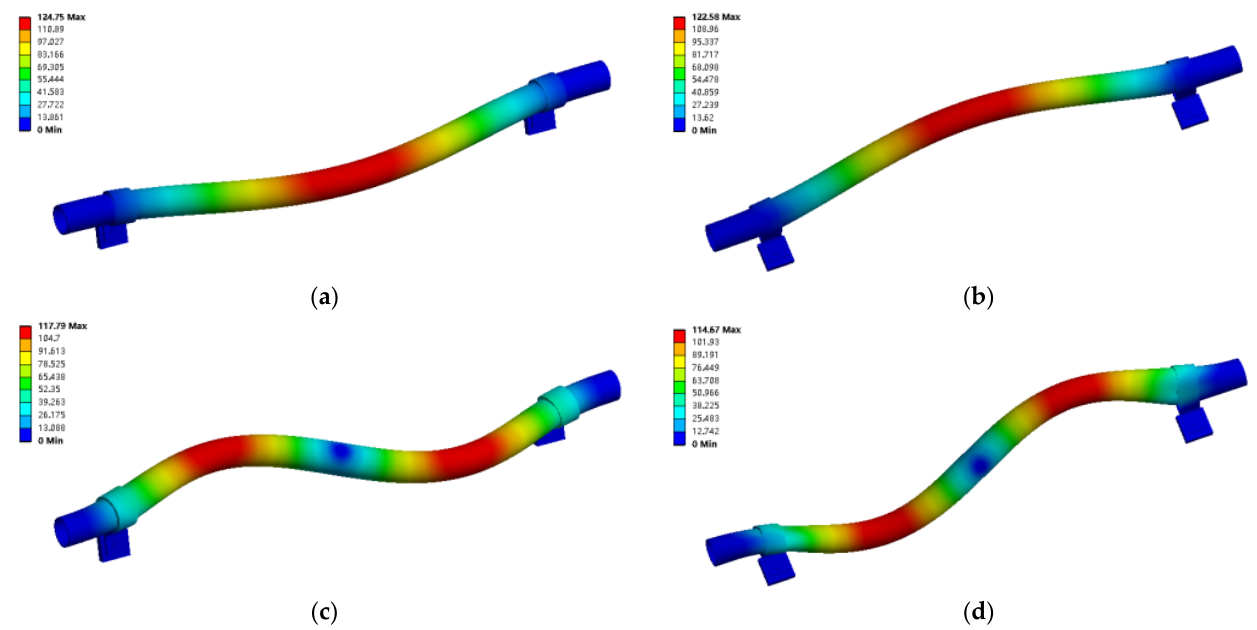
Figure 6. Vibration shape diagram of the 304 stainless steel clamp-piping system. ( a ) Level 1; ( b ) Level 2; ( c ) Level 3; ( d ) Level 4.